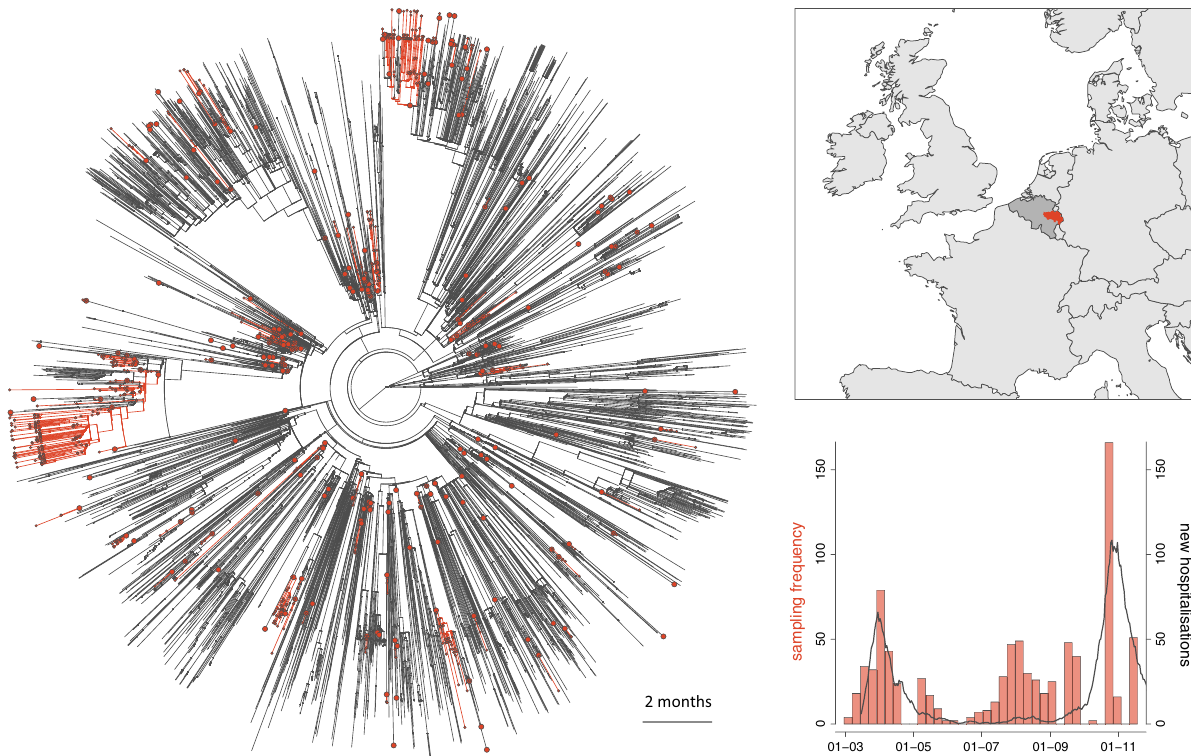
Figure 1. Time-scaled phylogenetic tree in which we identified phylogenetic clades introduced in the province of Liège (Belgium). We delineated those clades by performing a discrete phylogeographic reconstruction along the time-scaled phylogenetic tree while only considering two potential ancestral locations: “province of Liège” and “other location”. We identified a minimum of 244 lineage introductions (95% HPD interval = [239–250]) for 689 sequences sampled in the province of Liège. On the phylogeny, lineages circulating in the province of Liège are highlighted in red, and red nodes correspond to the most ancestral node of each clade. Apart from the phylogenetic tree, we also report a map of western Europe highlighting Belgium (in darker grey) and the province of Liège (in red), as well as a graph displaying both the number of sequences sampled through time and the daily number of new hospitalisations in the province of Liège (source: national public health institute of Belgium, Sciensano, https:// epist at. wiv- isp. be/